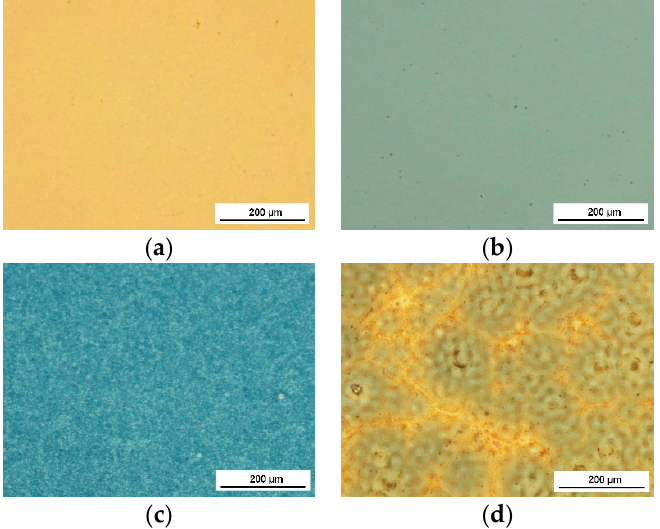
Figure 2. Microscopic images of one-component coatings: TiO 2 ( a ), Al 2 O 3 ( b ), ZrO 2 ( c ), and HAp ( d ) deposited on Ti6Al7Nb alloy substrates.